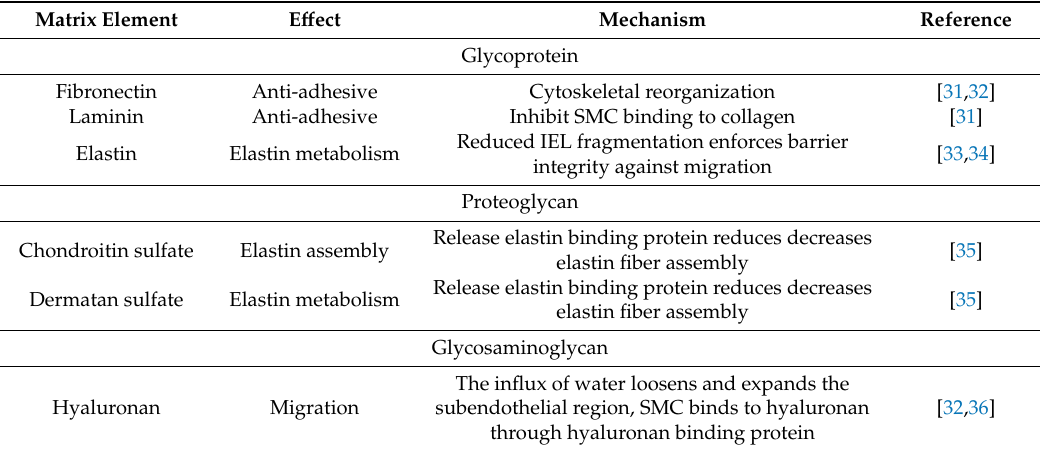
Table 3. Roles of matrix elements in ductus arteriosus (DA)